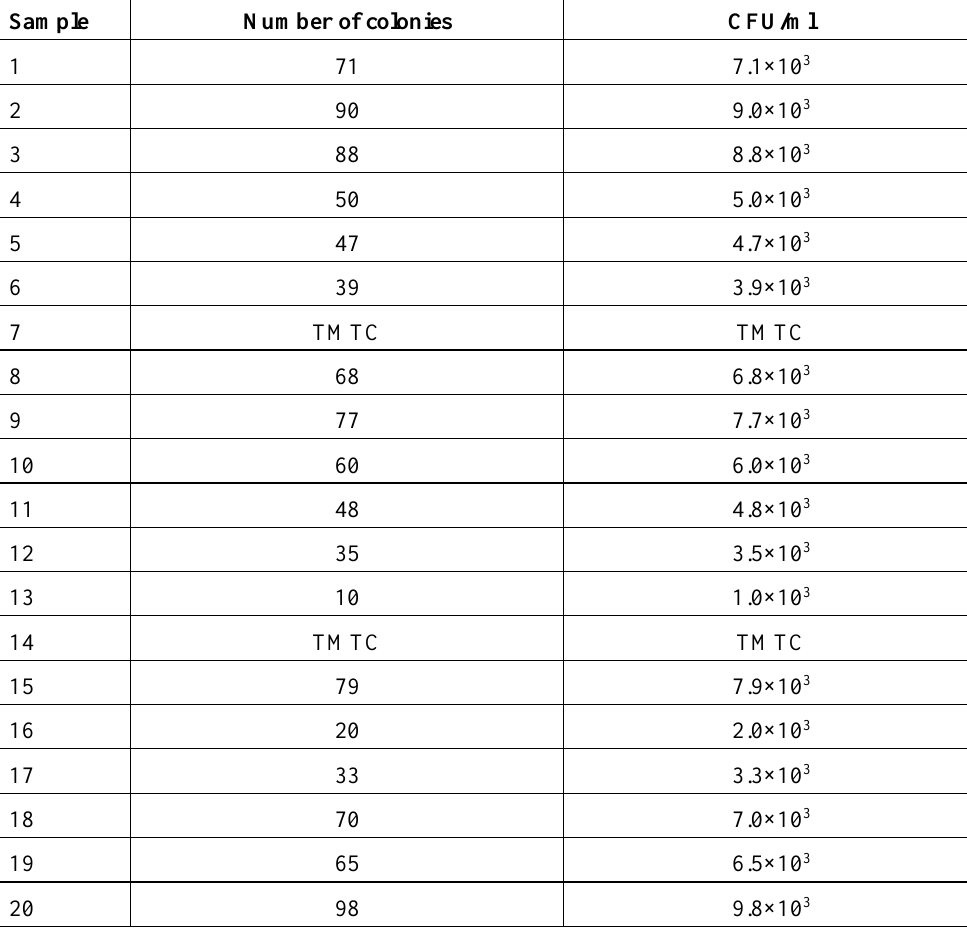
Table 1. Results of enumeration.